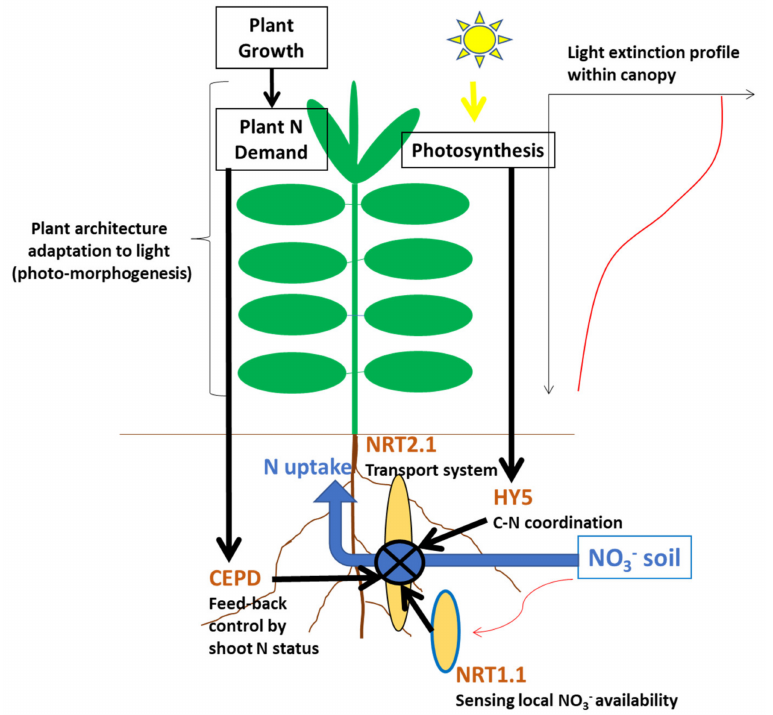
Figure 3. Schematic representation of N uptake regulation system of a plant growing within a dense crop. The regulation of the expression of gene NRT1.1 encoding the transport of nitrate via root plasma membrane is represented by dark arrows and the identification of corresponding molecules: ( i ) NRT1.2, a sensor of local NO 3 − availability in soil; ( ii ) C-terminally encoded peptide downstream (CEPD), a gluta-redoxine protein responsible for feedback control by plant N demand through N satiety signals; ( iii ) HY5, a transcription factor for the coordination between N and C acquisition by plants. For